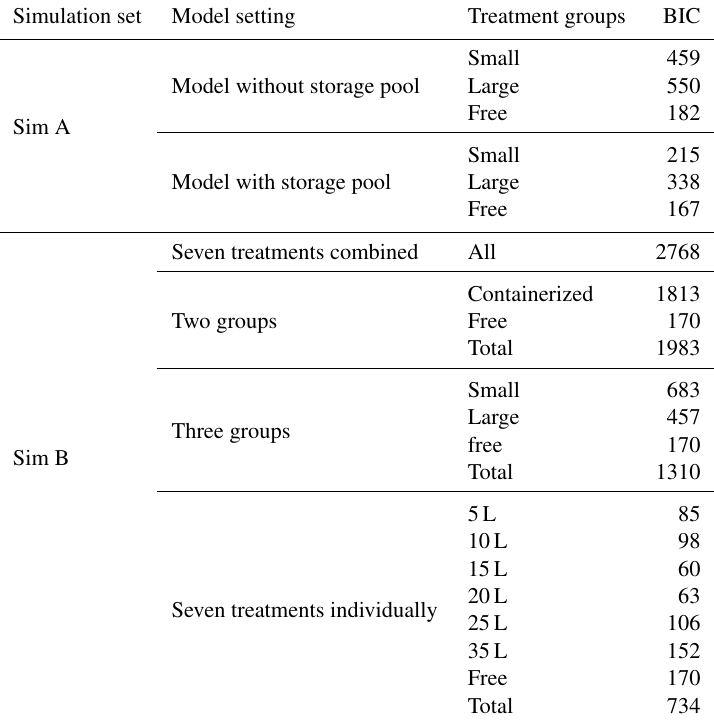
Table 3. BIC values from model fits. The lowest BIC values indicate the best performing parameter settings for any particular simulation. Note that for Sim A, leaf NSC data were not used to constrain either model to ensure that both models were fit to the same dataset, resulting in lower BICs compared to Sim B. Treatment groups are as follows: “small” – 5, 10 and 15L containers; “large” – 20, 25 and 25L containers; “free” – freely rooted seedlings; “All” – all data; “containerized” – all plants in containers. Simulation set Model setting Treatment groups BIC Small 459 Model without storage pool Large 550 Free 182 Sim A Small 215 Model with storage pool Large 338 Free 167 Seven treatments